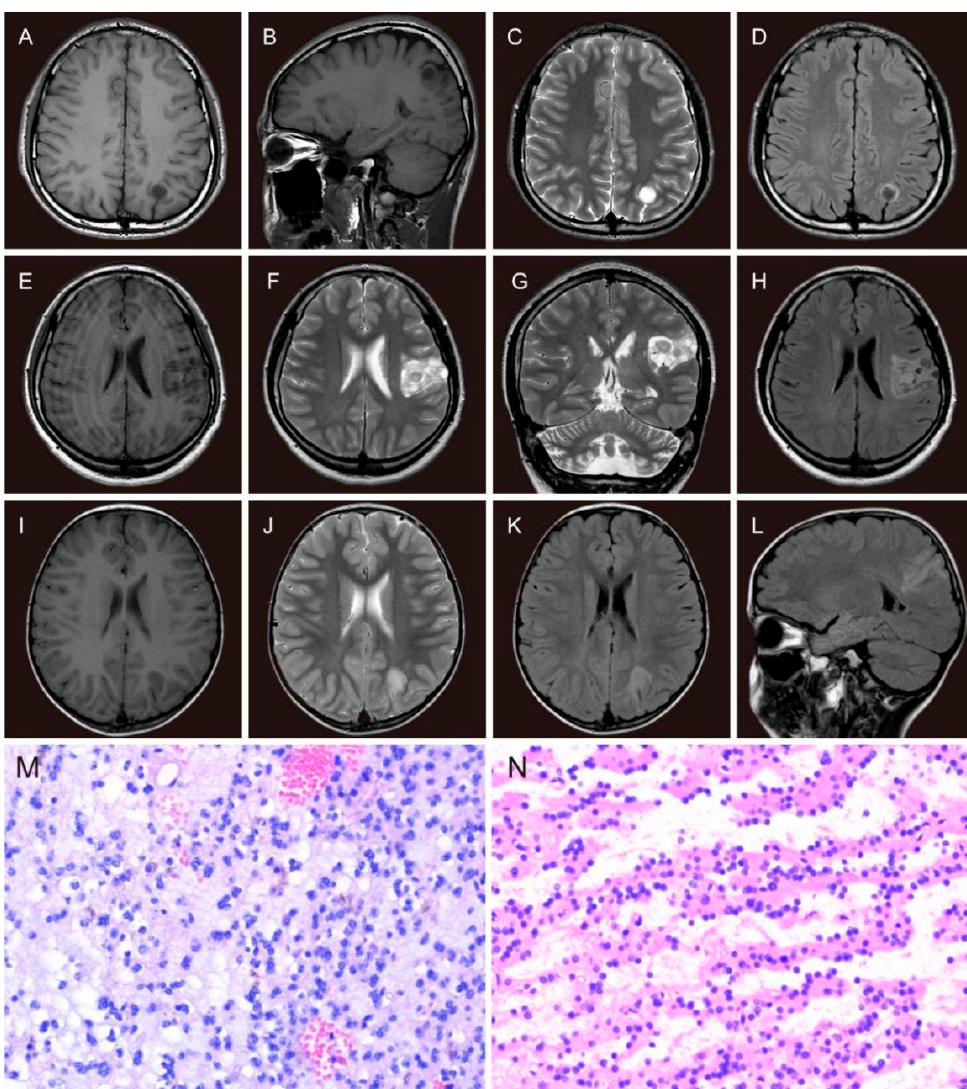
Figure 2. The MRI features and histopathological features of DNTs. The MRI features of type 1 ( A – D ): axial and sagittal slices, single cystic-like hypointensity on T1WI ( A , B ) and hyperintensity on T2WI ( C ), ring hyperintensity around the isointensity tumor with a clear gray-white matter boundary on FLAIR image ( D ); the MRI features of type 2 ( E – H ): axial and coronal slices, hypointensity on T1WI ( E ), hyperintensity on T2WI ( F , G ) and FLAIR image ( H ), all with a nodular-like iso-hypointensity; the MRI features of type 3 (dysplastic-like): axial and sagittal slices ( I – L ), slightly blurring of the gray-white matter demarcation with hypointense signal on axial T1WI ( I ), hyperintense signal on T2WI ( J ) and FLAIR images ( K , L ). Histopathological features of DNT ( M , N ): specific glioneuronal elements with a typical columnar structure composed of small oligodendrocytes and neurons floating within an interstitial fluid (H&E, × 200); ( N ): tumor cells were “striped” in loose areas of tumor tissue (H&E, ×